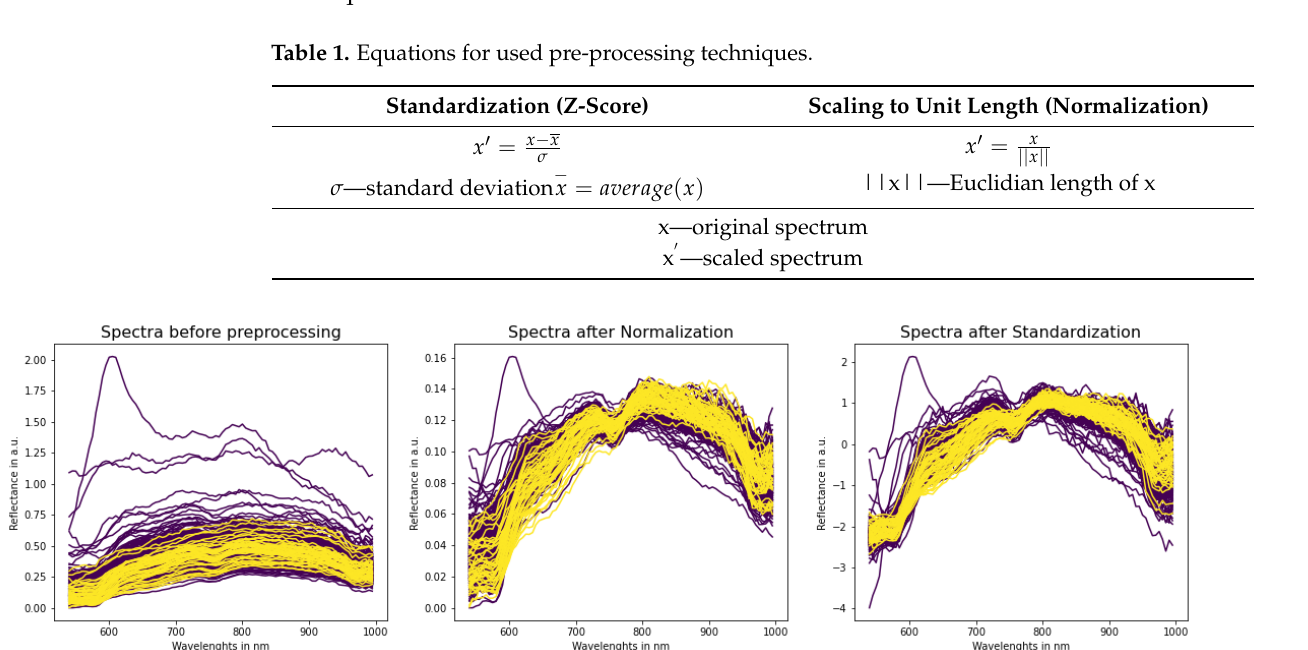
Figure 2. Examples of spectra before ( left ) and after pre-processing techniques ( middle , right ). Please note that y-axes have different scales. Non-malignant spectra are purple and cancerous are yellow.